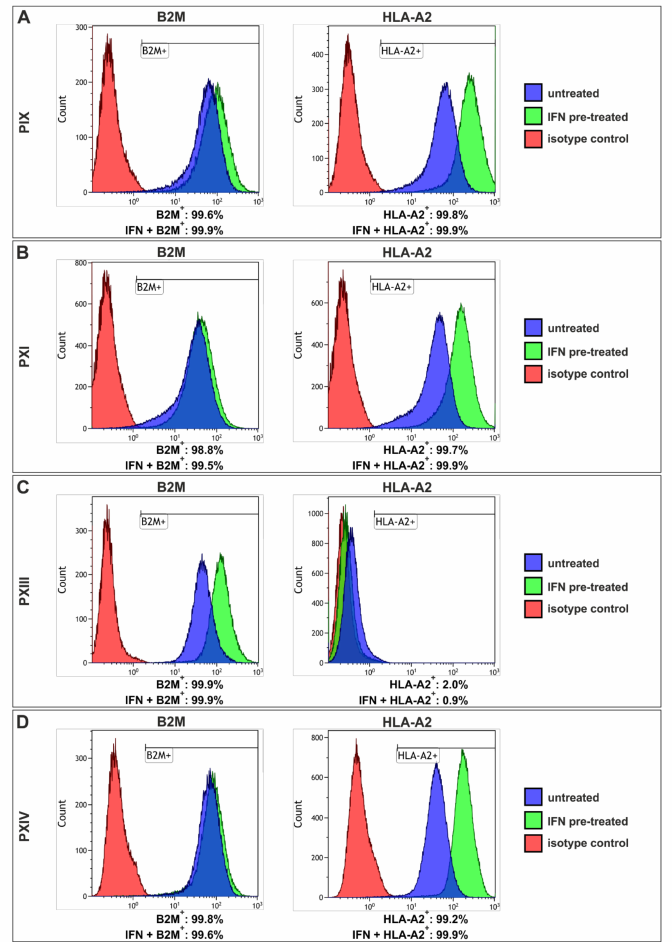
Figure 7. Flow cytometry revealed high-level expressions of beta 2-microglobulin and human leukocyte antigen A2 in three prostate cancer stem cell populations. ( A – D ) Analyses showed over 98% beta 2-microglobulin (B2M) + cells in prostate cancer stem cells (PCSCs) (left panel, blue graphs), similar to interferon gamma (IFN γ ) pre-treated cells (green graphs). The human leukocyte antigen A2 (HLA-A2) staining (right panels) in PIX, PXI and PXIV PCSCs revealed more than 99% positive cells ( A , B , D ). The PCSC population PXIII displayed a maximum of 2% HLA-A2 + cells ( C , right panel) when untreated (blue graph), and only 0.9% after treatment with IFN γ (green graph). For all the analyses, isotype controls are displayed as red